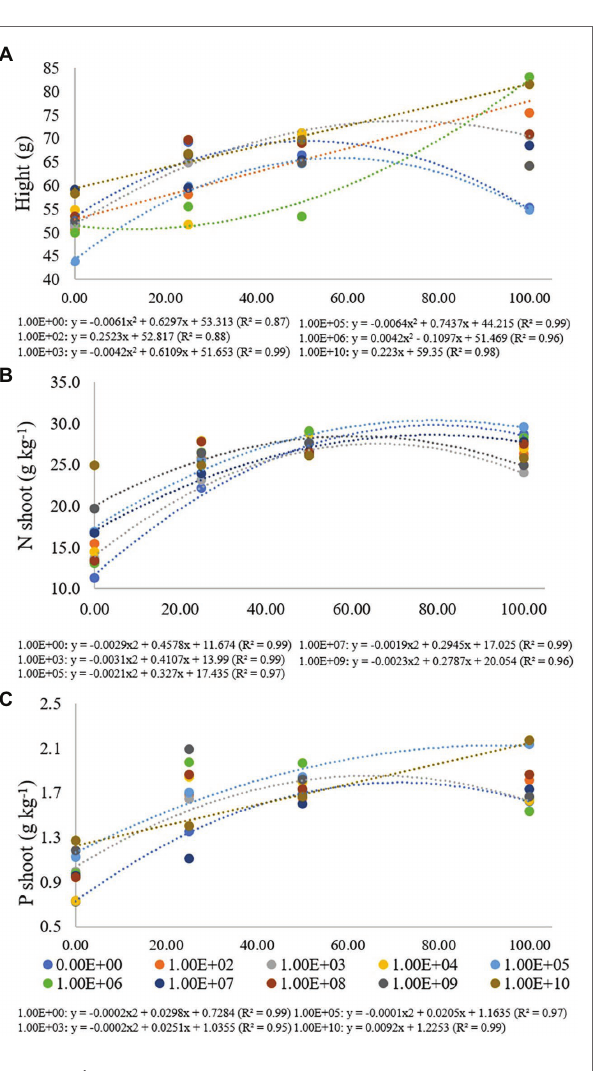
FIGURE 4 | Regression data for the unfolding of the interaction between inoculum concentrations and fertilization doses in relation to (A) height (cm) of maize plants; (B) nitrogen (g kg − 1 ) and (C) phosphorus (g kg − 1 ) concentration in maize plant shoots. The X-axis indicates fertilization dose in percentage— colored circles and the equation—0.00E+00 means no inoculation (control); 1.00E+02 means 1 × 10 2 CFU ml − 1 ; 1.00E+03 means 1 × 10 3 CFU ml − 1